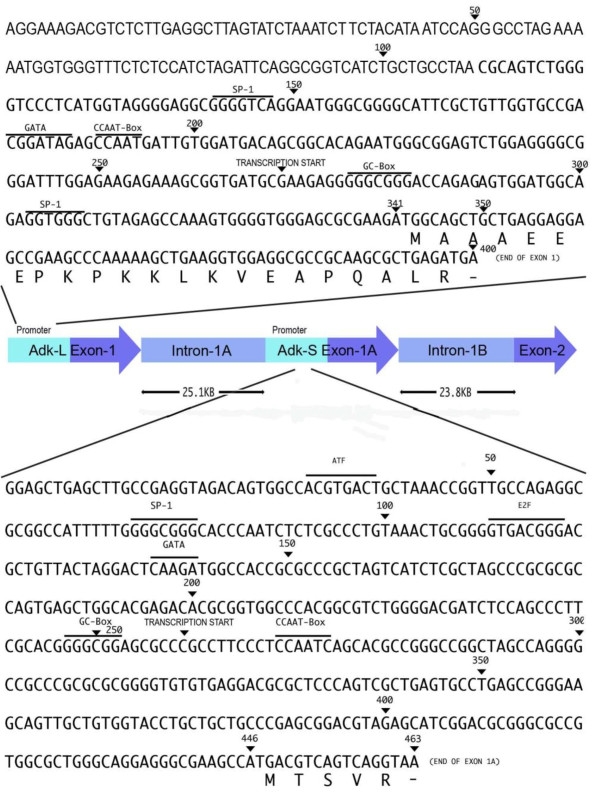
A schematic drawing showing the genomic organization of the first exons and promoter regions for the AdK-L and AdK-S genes in the human genome. The AdK gene (both AdK-L and AdK-S isoforms) in human is comprised of 11 exons. Except for the first exons, all the remaining exons (not shown here) are common to these isoforms. The Exon-1 and promoter region for the AdK-L isoform were identified in earlier work [32,36]. The intron-1 for the AdK-L is now shown to contain the first exon for the AdK-S isoform. The first exons for the AdK-L and AdK-S isoforms encode for all the amino acids that distinguish these two isoforms. The upstream regions of both exons contain binding sites for several transcriptional factors, only some of which are shown here. The introns and exons are not drawn to the scale in this diagram.